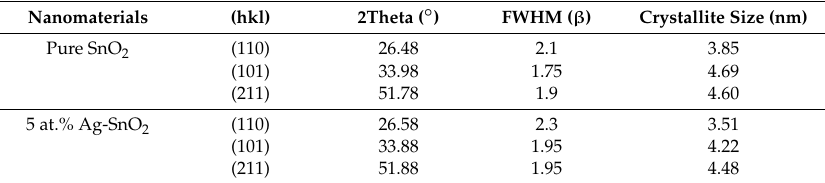
Table 1. Different XRD parameters for the determination of crystallite sizes.